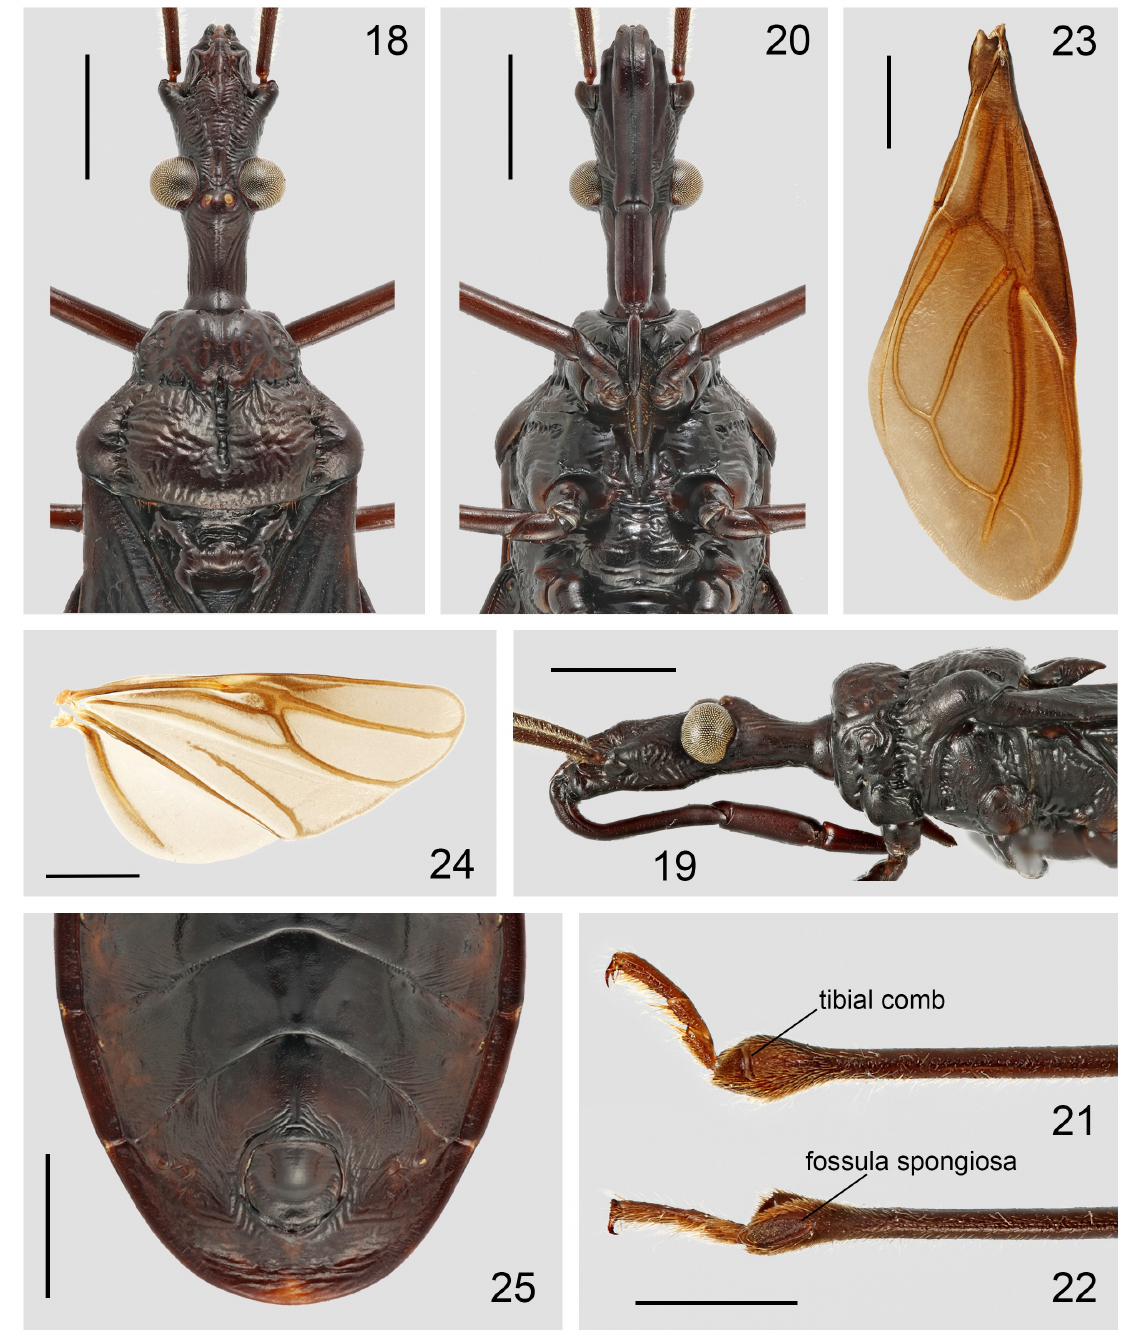
Figs 18–25. Xenorhyncocoris attractivus sp. nov., paratype, ♂ (CAU-RE-0000006). 18 . Anterior part of body, dorsal view. 19 . Same, lateral view. 20 . Same, ventral view. 21 . Anterior part of right fore leg, dorsal view. 22 . Same, lateral view. 23 . Right fore wing, dorsal view. 24 . Right hind wing, dorsal view. 25 . Posterior part of abdomen, ventral view. Scale bars: 18–20, 23–25 = 3.00 mm; 21–22 = 2.00